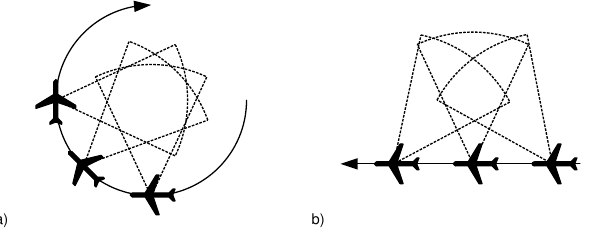
Fig.1. TomographicflightpathsforGLORIA.Acircularflightpathisschematicallyshowninpanel (a) , while a linear flight path is depicted in panel (b) . In practise, the measurement density is much denser Fig. 1. Tomographic flight paths for GLORIA. A circular flight path thandepictedhereandtheinstrumentispannedalsoforthecircularflightdepictedinpanel(a). is schematically shown in (a) , while a linear flight path is depicted in (b) . In practise, the measurement density is much denser than depicted here and the instrument is panned also for the circular flight depicted in (a)